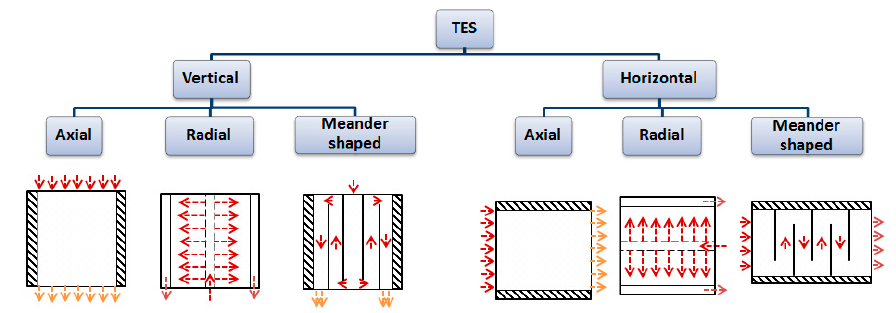
Figure 5. Matrix of variants for TES.